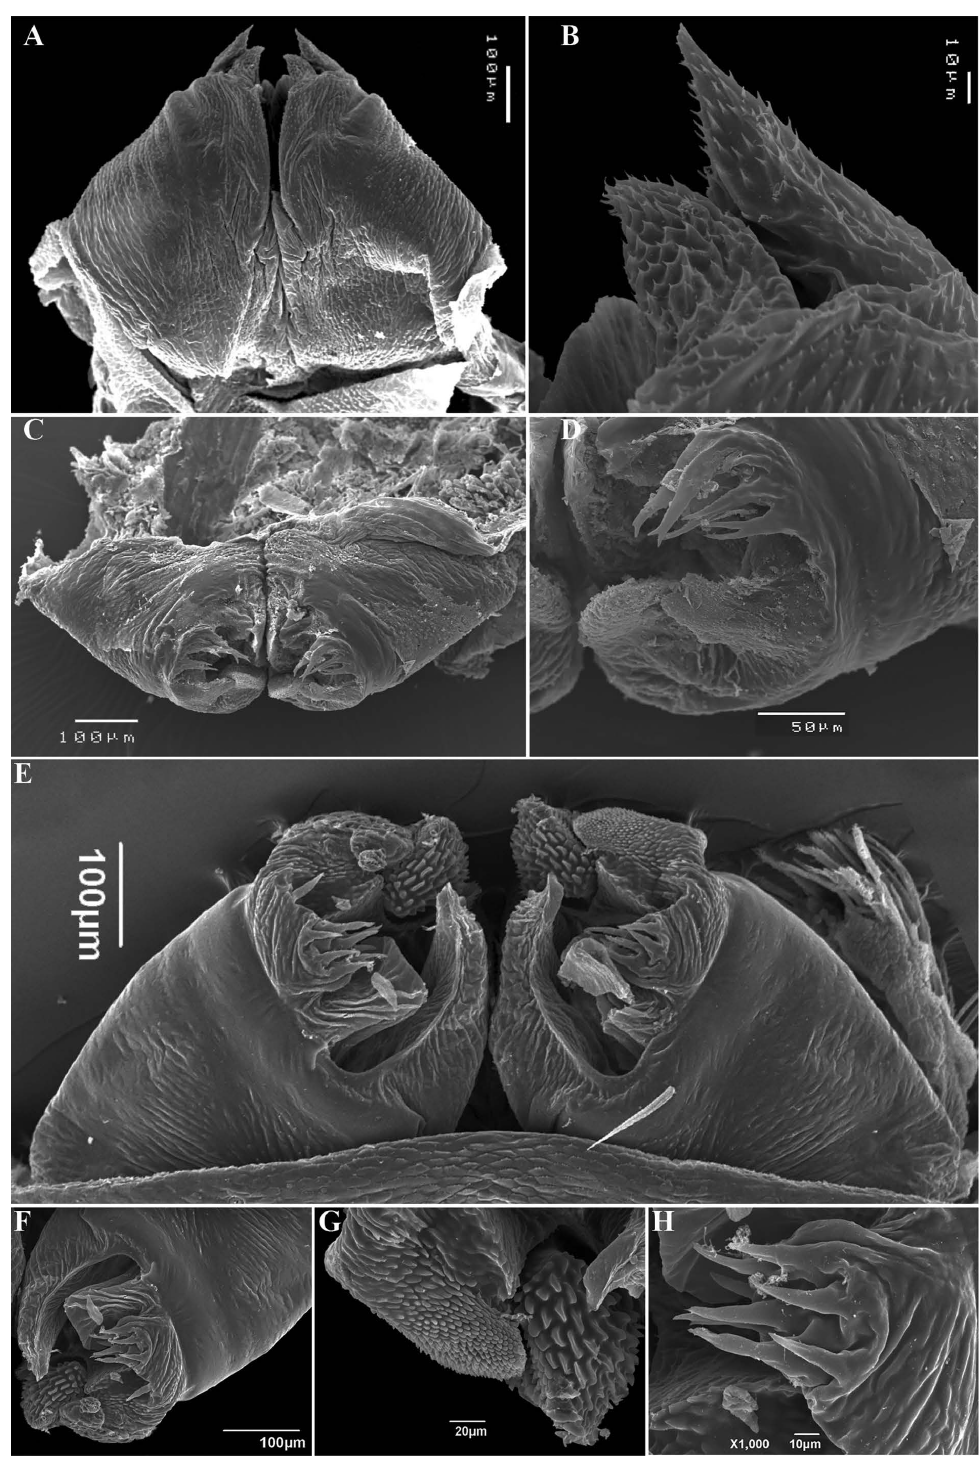
Fig. 8. Charinus Simon, 1892, male gonopods. A–B . Charinus acaraje Pinto-da-Rocha, Machado & Weygoldt, 2002 (MNRJ 9297), ventral view (A) and detail of dorsal lobe (LoD) and lateral lobe 1 (LoL1). C–D . Charinus brasilianus Weygoldt, 1972 (MNRJ 9226), posterior view (C) and detail of lateral lobes 1 and 2 (LoL1, 2), dorsal lobe (LoD) and lamina medialis (LaM) (D). E–H . Charinus carajas Giupponi & Miranda, 2016 (MZSP 29126), ventral view of gonopod (E), detail of sinistral side of gonopod (F), detail of LoL1 and LoD (G), and detail of LoL2